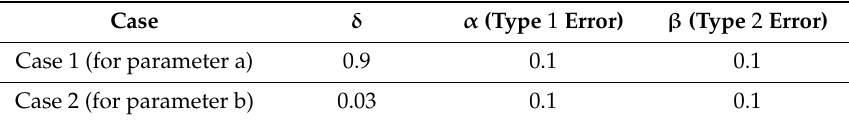
Table 9. Case for applying the sequential probability ratio test (SPRT).